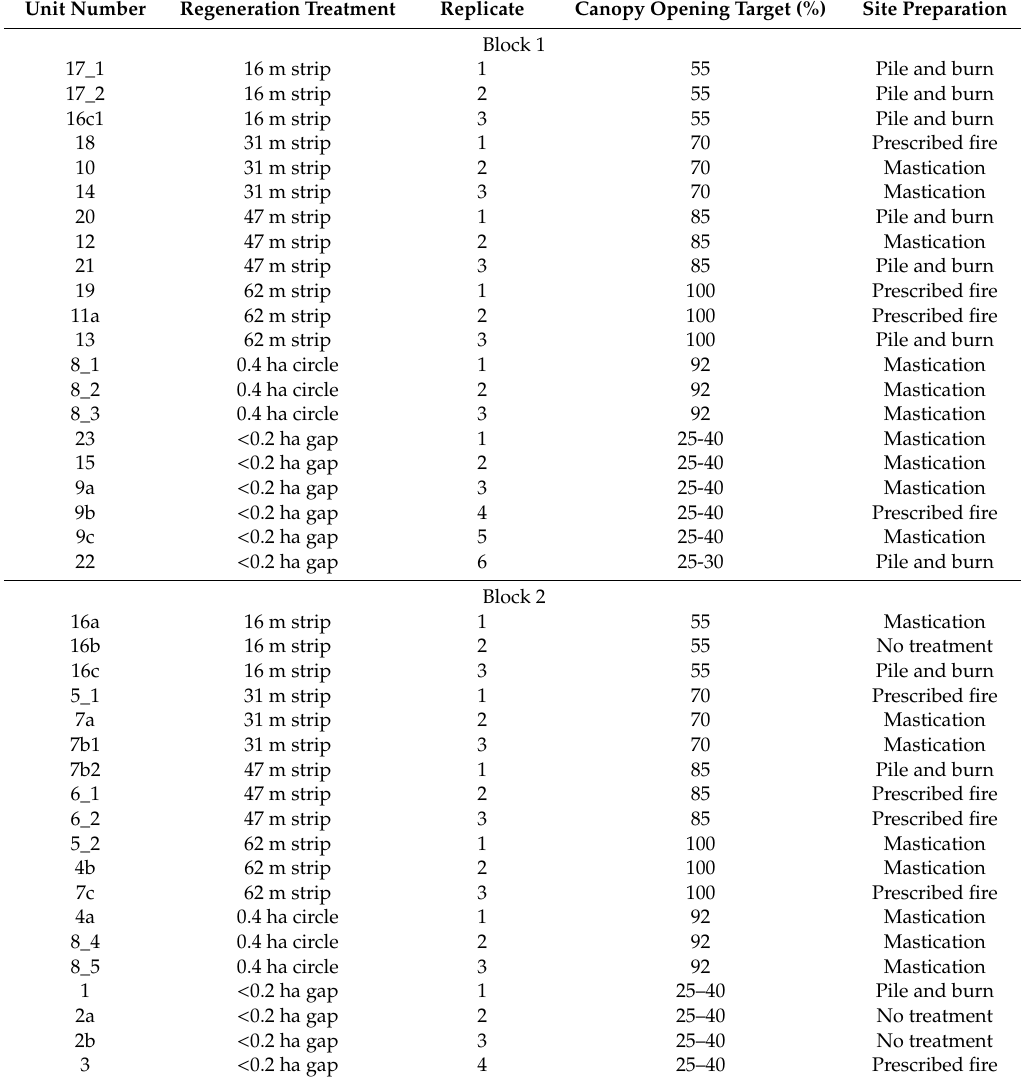
Table A1. Regeneration harvest and site preparation study design [10]. Western white pine thresholds for regeneration establishment (25 to 55% canopy opening, competitive advantage [55 to 92%], and free-to-grow [ > 92%]) [9], soil substrates (blackened soil, mineral, organic, and masticated), and a combination of strip cuts, gaps, and circles were used to create the range of opening sizes. Site preparation treatments were replicated a minimum of five times each across the entire study area and included grapple pile and burn (pile and burn), shredded wood (mastication), prescribed fire, and no site preparation (no treatment). The mechanical treatments site preparation treatments were randomly applied on slopes less than 50% because machine limitations prevented grapple pile machines and masticators to operate on steep slopes. The prescribed fire was randomly applied on steep slopes and when residual tree species were fire